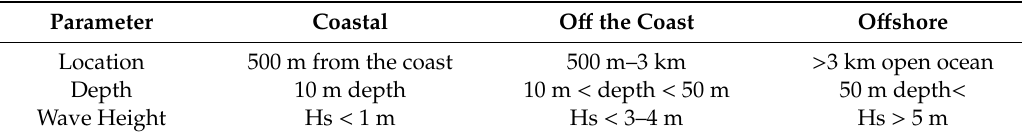
Table 1. Site classification proposed by the Food and Agriculture Organization (FAO) in 2009 (source: [10]).